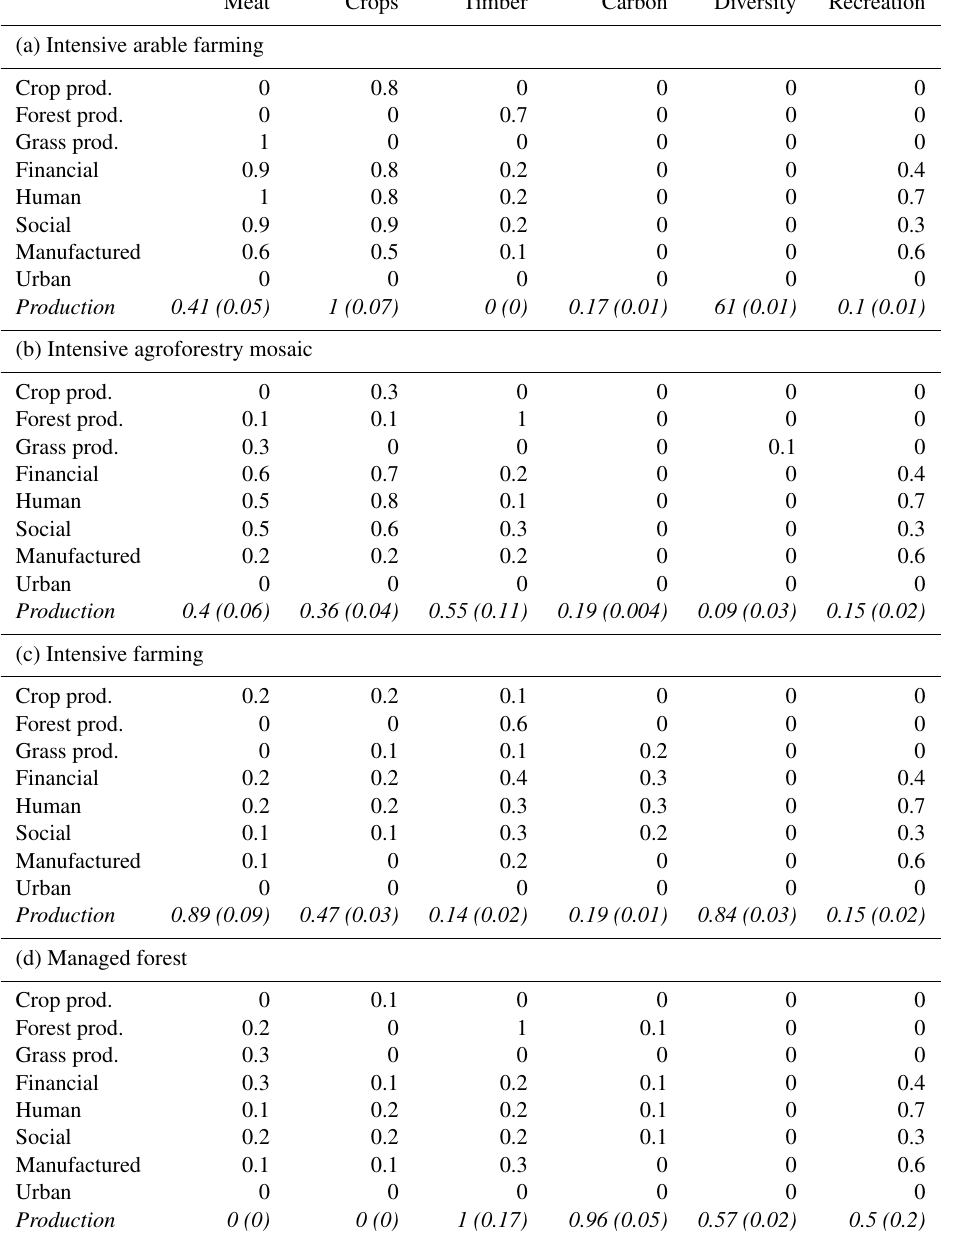
Table A3. (a)–(q) Tables showing the sensitivities λ c,t of each AFT to capital levels and maximum service production levels o s,t (italics) (Eq. 1). Values in brackets are the standard deviations of Gaussian distributions used in some simulations to randomly assign production levels to individual agents. Standardised units of production are shown for comparability and consistency with model calculations.